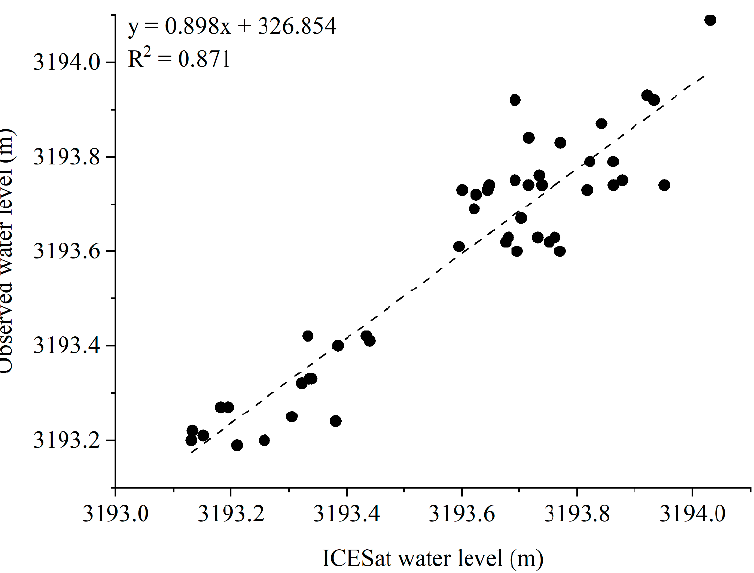
Figure 3. Observed water level vs. ICESat water level in the Xiashe hydrological station from 2003 to 2009. RMSE = 0.099 m; R = 0.933.